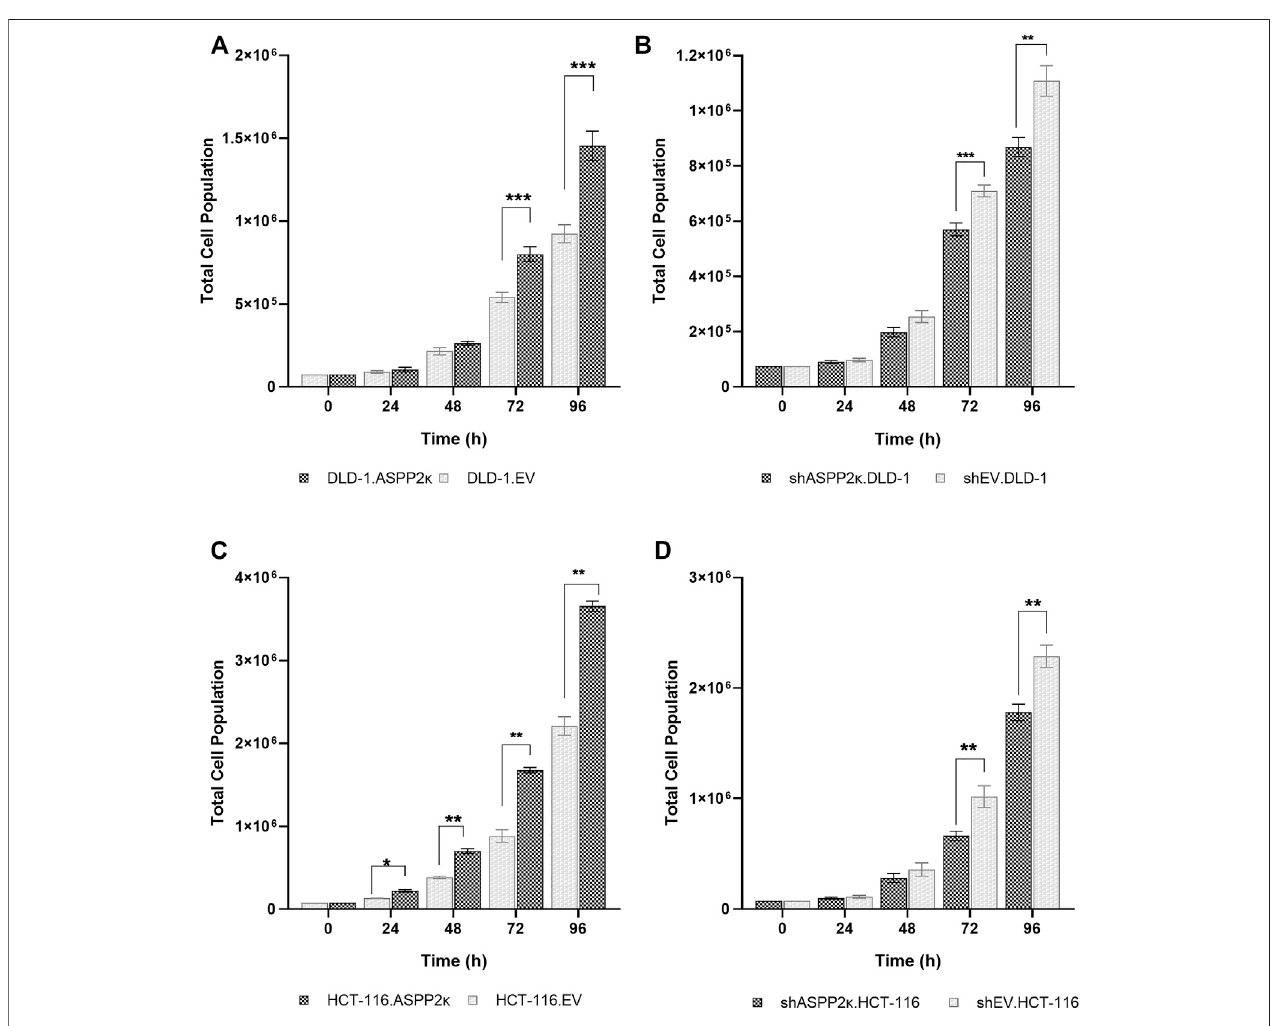
FIGURE4| Celldoublingtimes ofCRC cell lines independence ofASPP2 κ : (A) DLD-1or (C) HCT116 strainsoverexpressing theASPP2 κ isoform or (B) DLD-1or (D) HCT116 ASPP2 κ silenced strains are shown. EV, empty vector. Statistical test: two-way ANOVA. *** p < 0.001, ** p < 0.01, * p < 0.05.